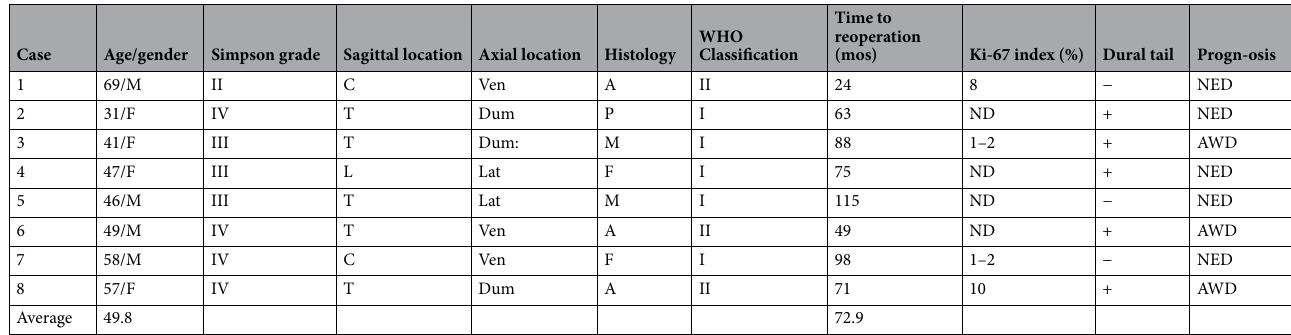
Table 4. Summary of patients with reoperation due to tumor recurrence. C cervical, T thoracic, L lumbar, Lat lateral, Ven ventral, Dum dumbbell, M meningeothelial, P psammomatous, F fibrous, T transitional, A atypical, NED no evidence of disease, AWD alive with disease.